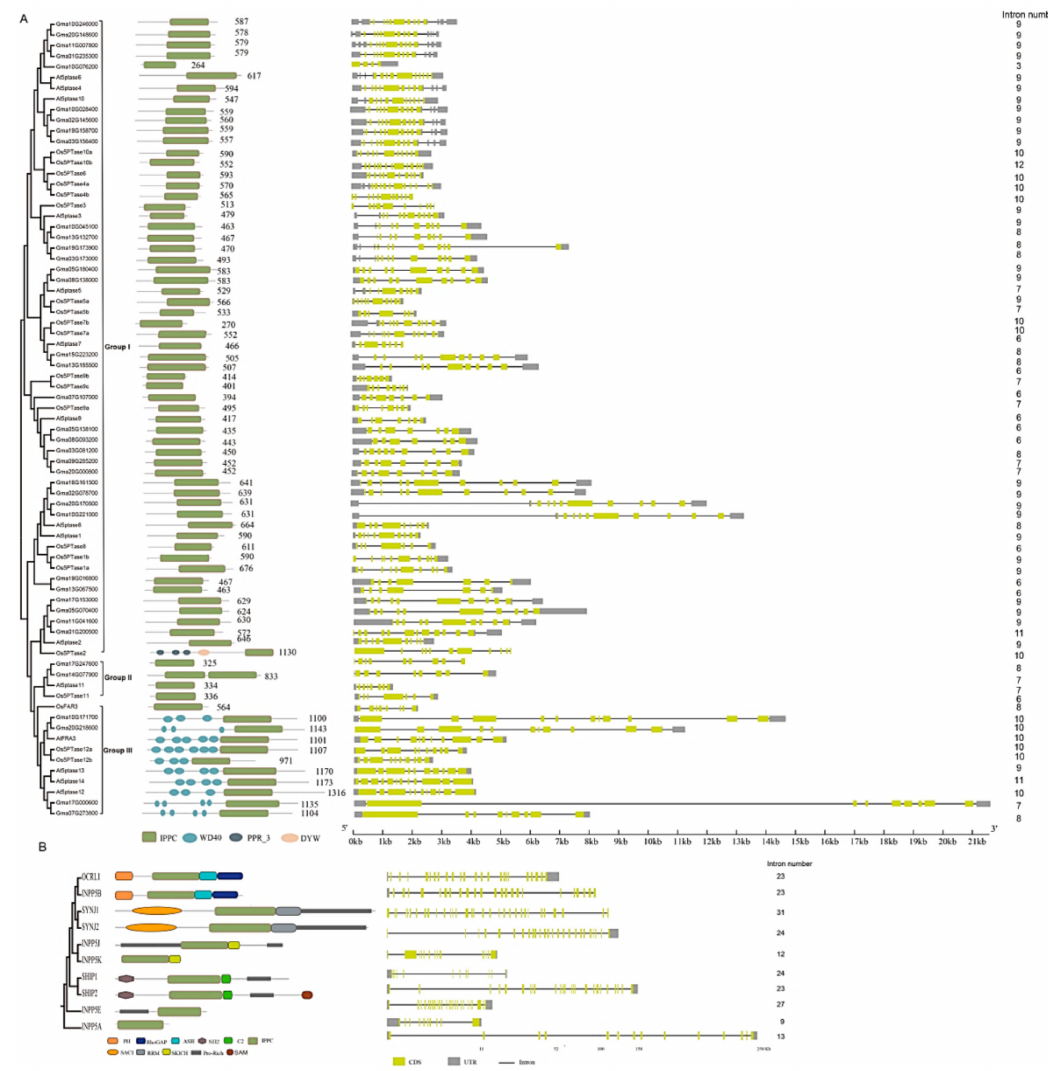
Figure 4. Phylogenetic relationships, exon / intron structure, and domain organization of 5PTase genes in Arabidopsis , rice, soybean ( A ), and humans ( B ). The motif architecture is demonstrated as colored boxes. IPPC: inositol polyphosphate phosphatase catalytic domain; WD40: WD40 / beta-transducin repeats domain; PPR_3: pentatricopeptide repeat domain; DYW: DYW_deaminase domain. The yellow boxes represent exons, the black lines represent introns, and the gray boxes refer to untranslated regions